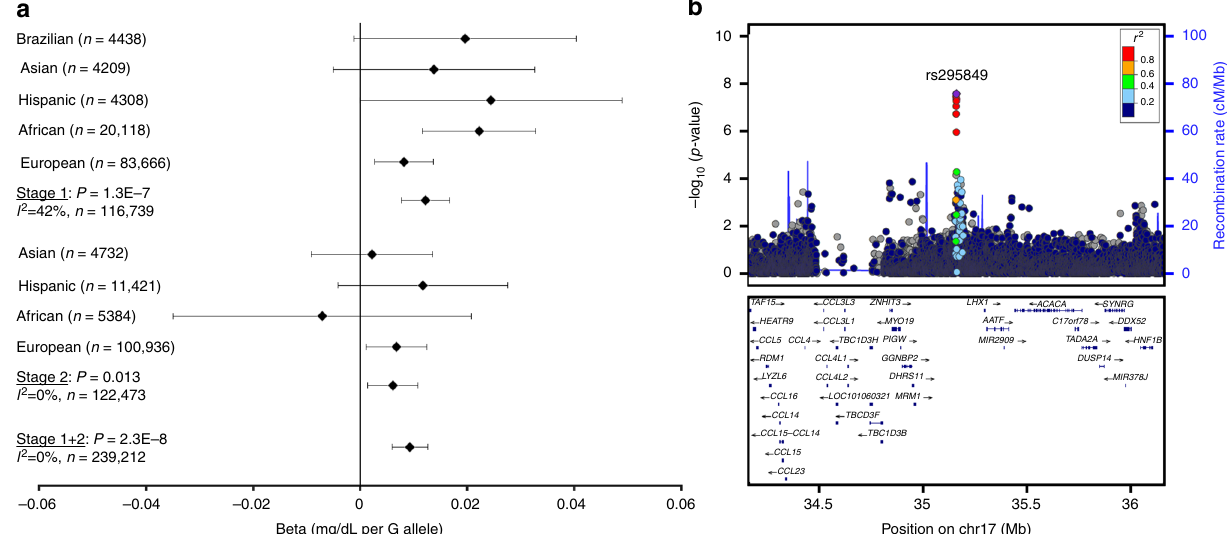
Fig. 3 Interaction of rs295849 near LHX1 with physical activity on HDL cholesterol levels. The beta and 95% con fi dence intervals in the forest plot ( a ) is shown for the rs295849 × physical activity interaction term, i.e., it indicates the increase in logarithmically transformed HDL cholesterol levels in the active group as compared to the inactive group per each G allele of rs295849. The − log 10 ( P value) in the association plot ( b ) is also shown for the rs295849 × physical activity interaction term. The P values are two-sided and were obtained by a meta-analysis of linear regression model results. The fi gure was generated using LocusZoom (http://locuszoom.org)